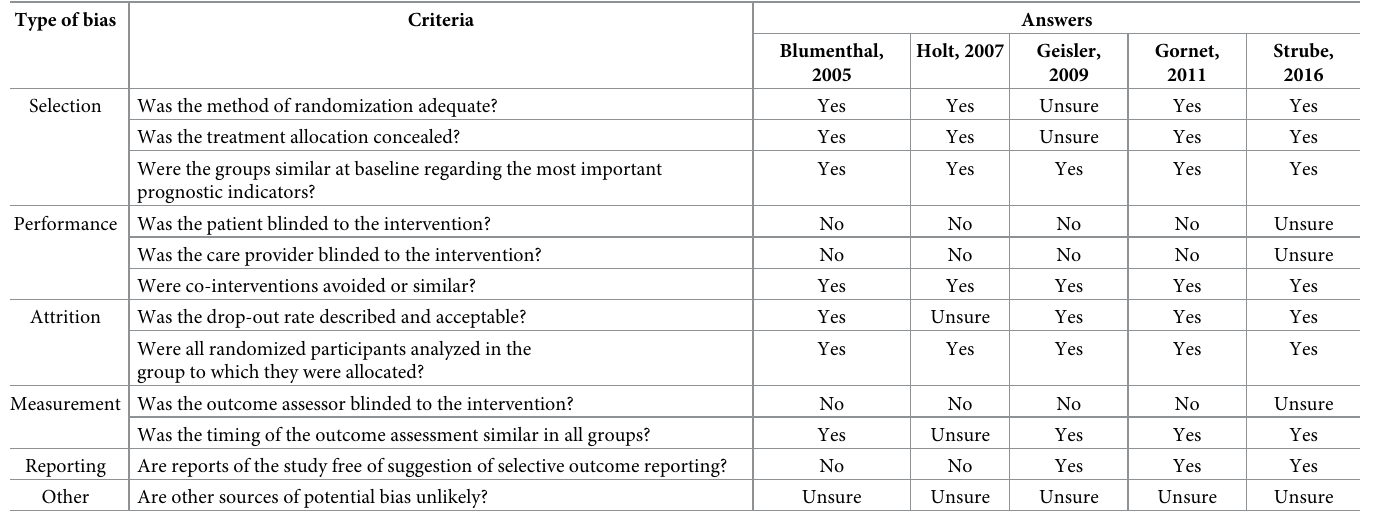
Table 2. Risk of bias assessment of included RCTs.